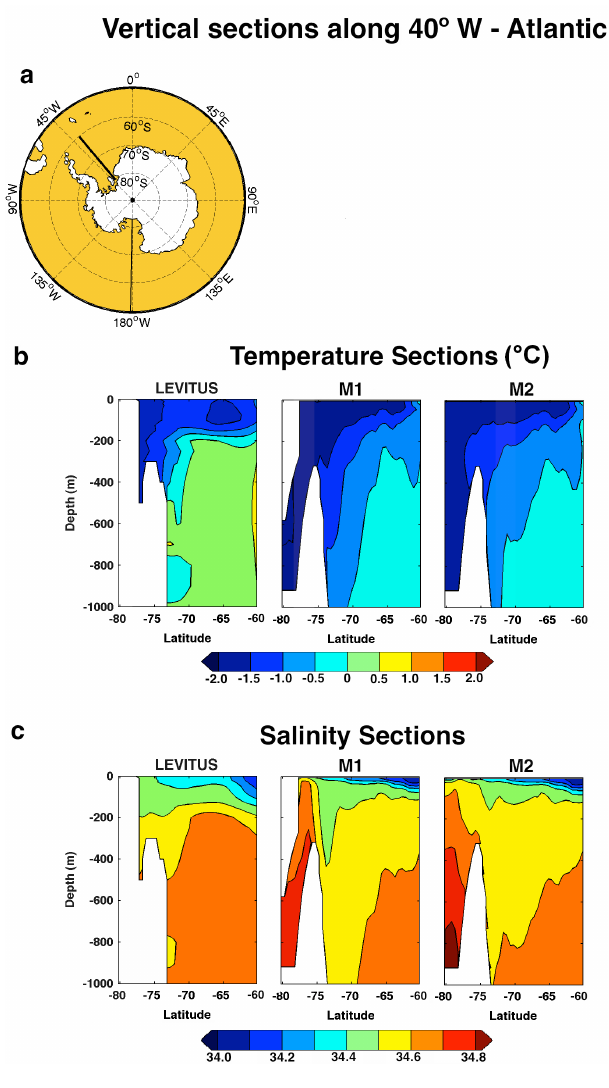
Fig. 5. Vertical sections along the Flichner–Ronne Ice Shelf at 40 ◦ W (a) of annual mean temperature (b) and salinity (c) for Levitus and model climatologies.